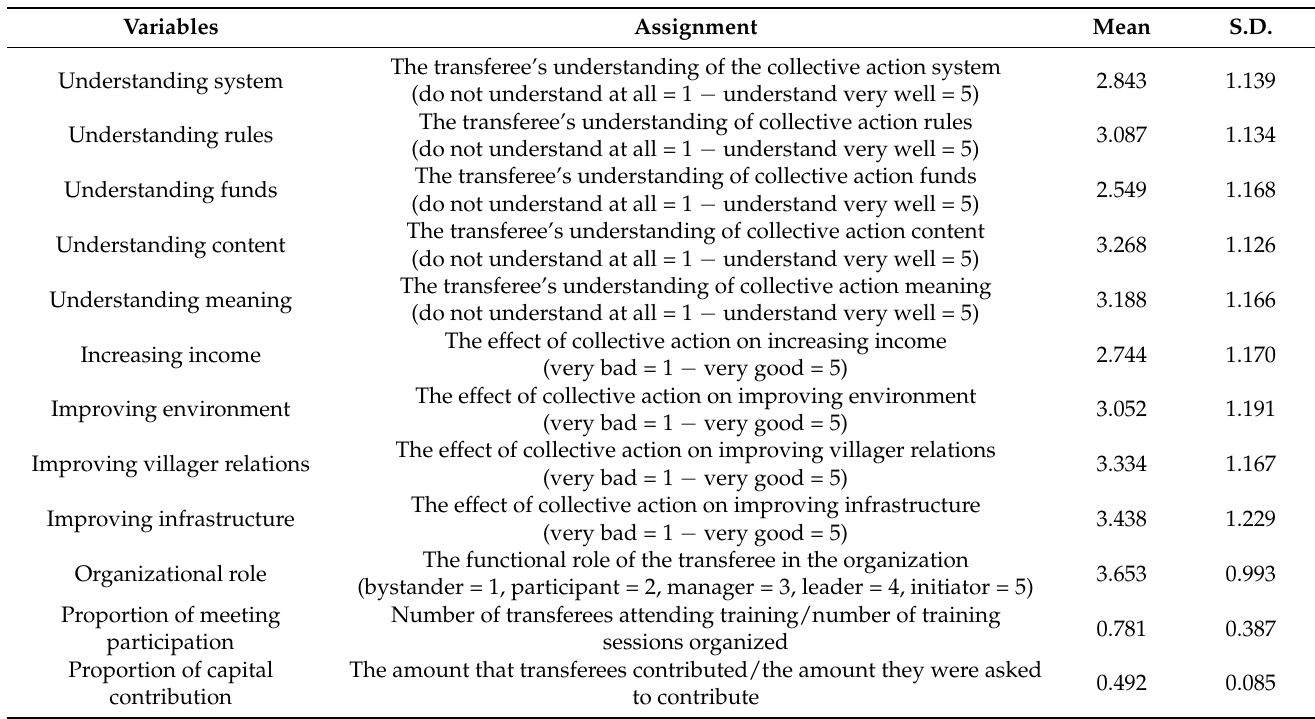
Table 3. Descriptive statistics of collective